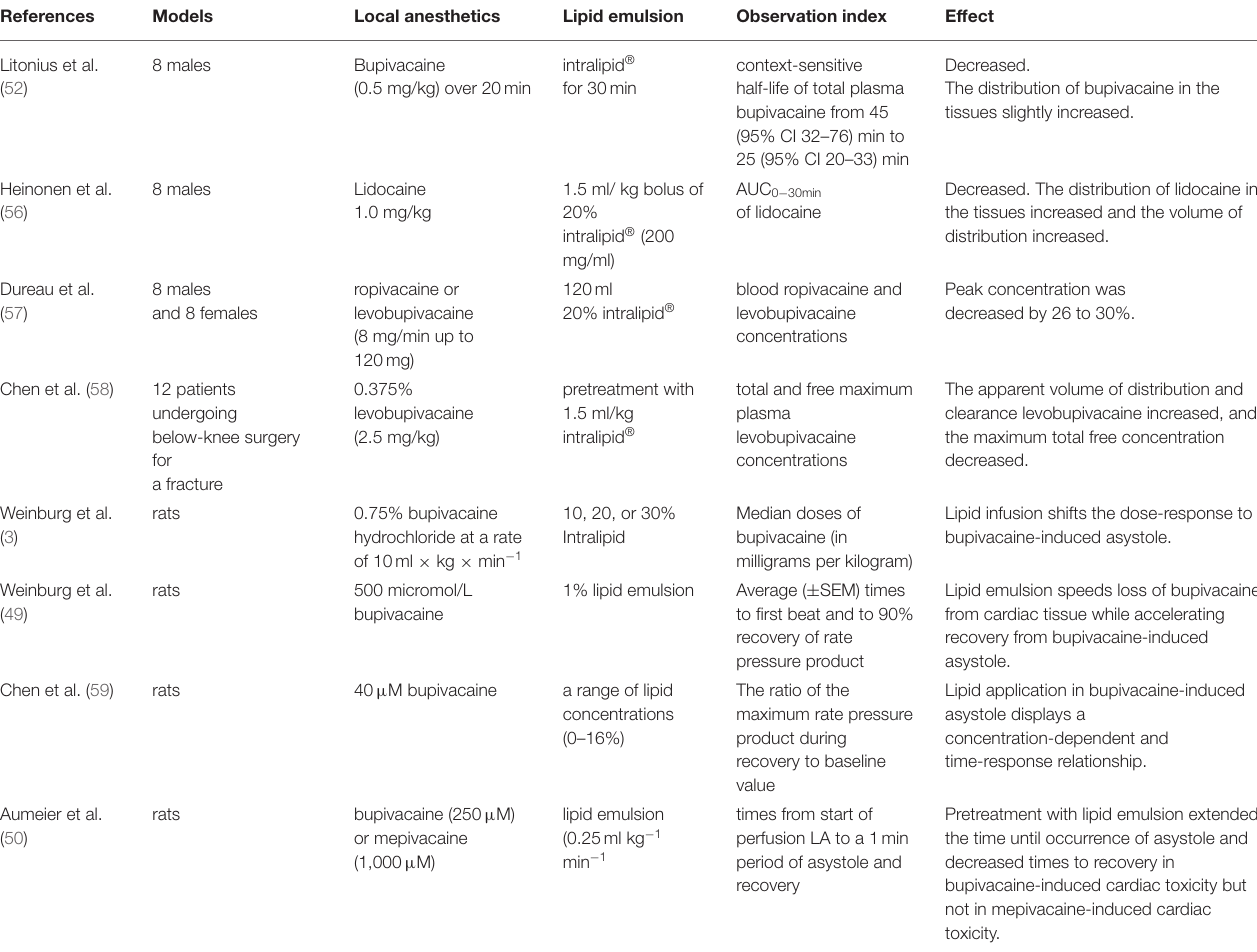
TABLE 1 | The human clinical trials and animal experiments support the “lipid sink” and “lipid shuttle”